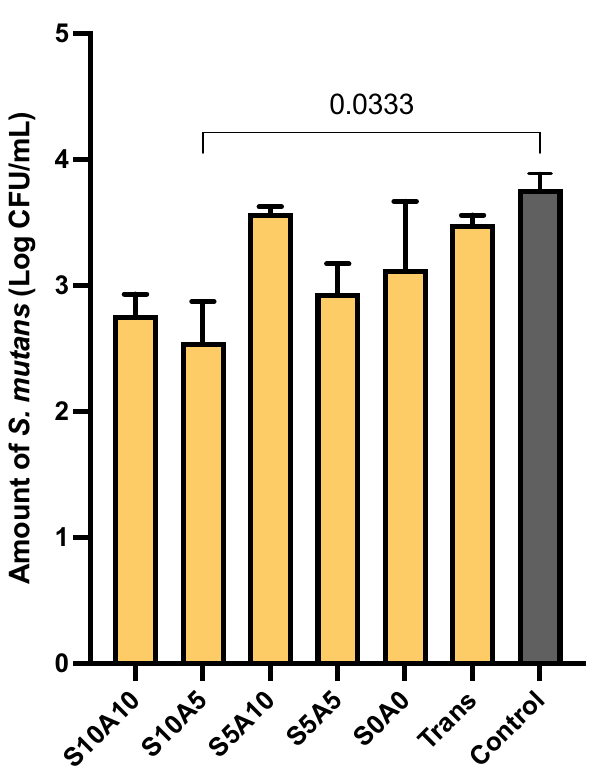
Figure 6. Amounts of S. mutans in all materials compared to the blank control (no material) (mean ± SD, n = 3). The amounts of released ions from S0A0 and Trans were under the detection limit. Lines indicate p <